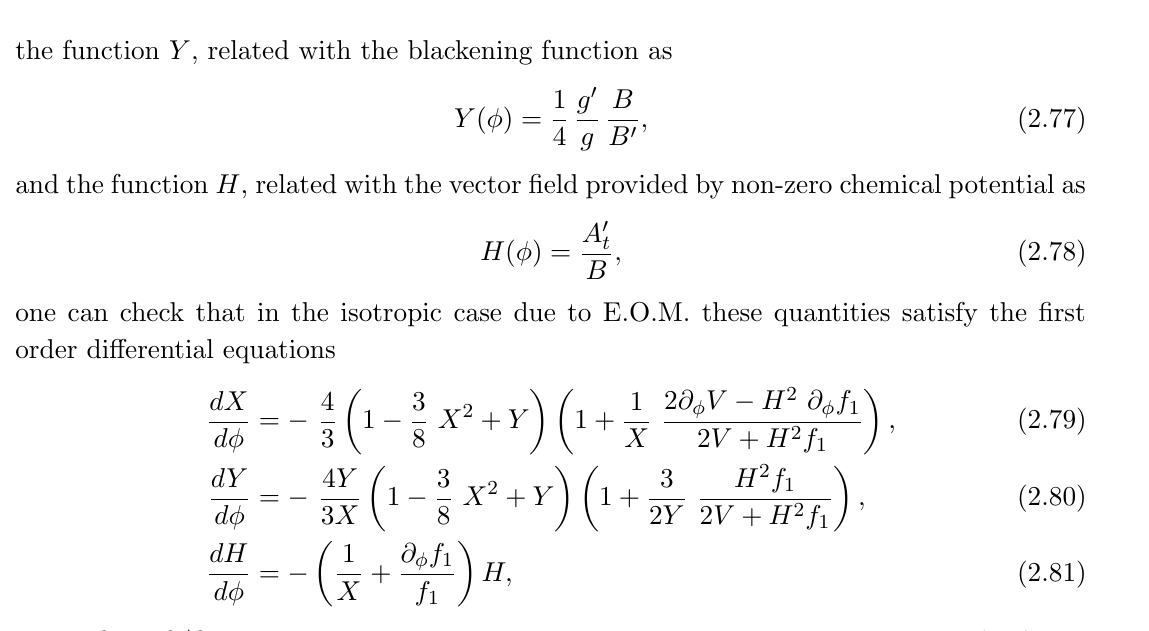
Figure 11 . The running coupling as function of the energy scale (A) and the RG (cid:13)ow (B) in isotropic and anisotropic (cid:23) = 4 : 5 case; the plot legends are the same for both